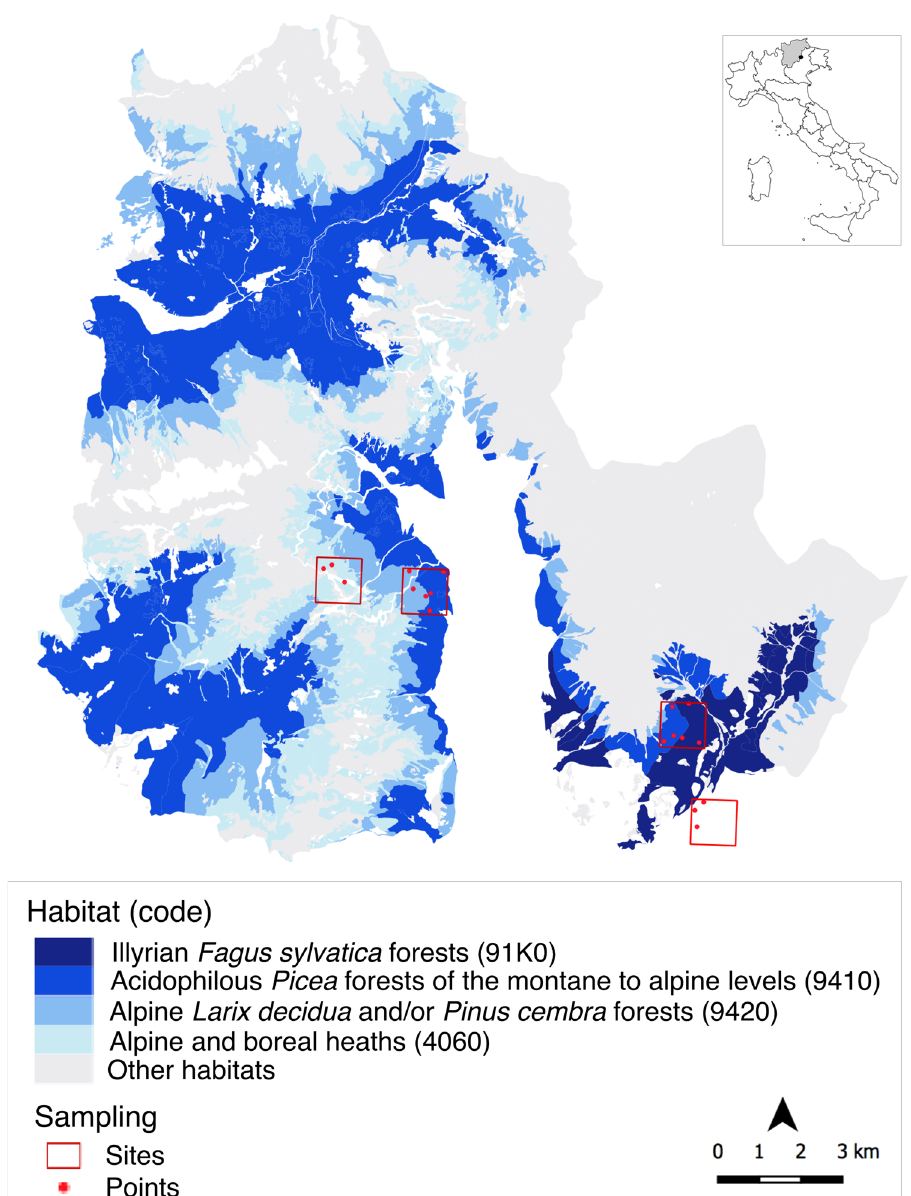
Figure 1. The sampling area in the National Park of Paneveggio–Pale di San Martino, Italy. The habitats in quadrats (sites) and sampling points (points) that were selected for the study are reported, as generated in